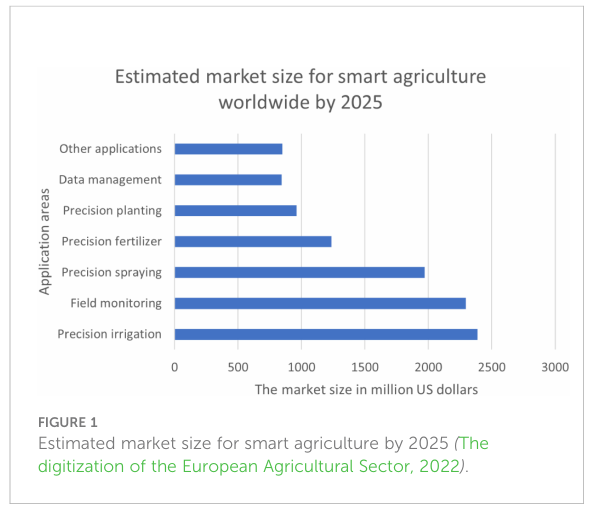
FIGURE 1 Estimated market size for smart agriculture by 2025 ( The digitization of the European Agricultural Sector, 2022 )